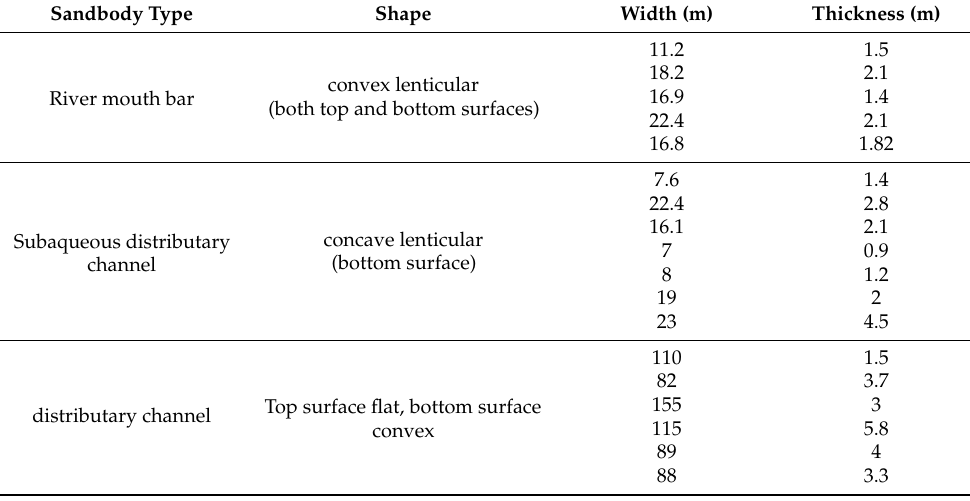
Table 3. Measurements of Jurassic delta from outcrop sections in Yichang.